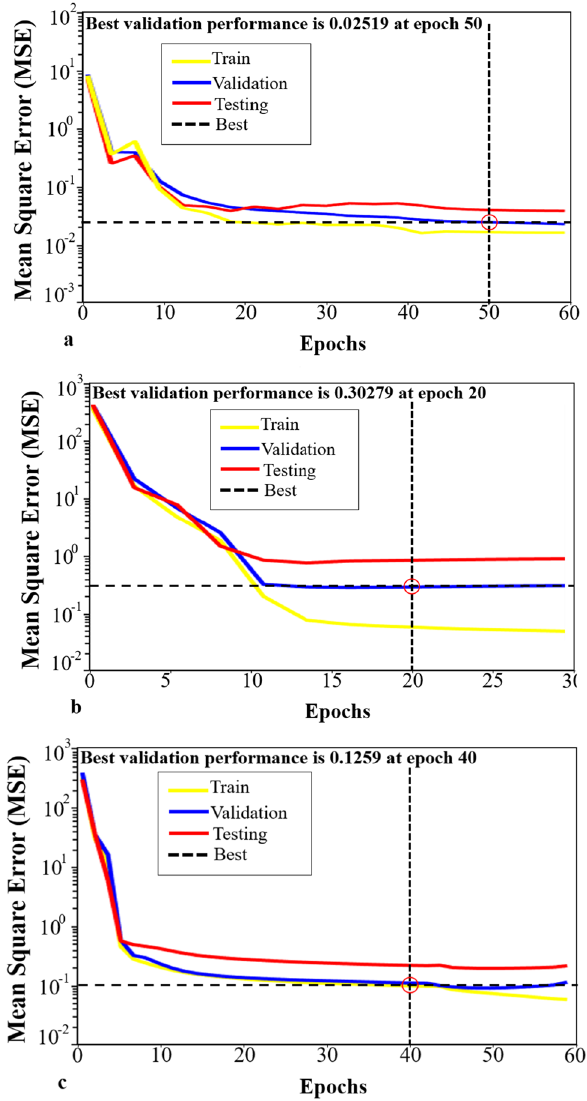
is 0.3 at epoch 20th. ( c ) The best validation performance of cumulative CO 2 retained is 0.12 at epoch